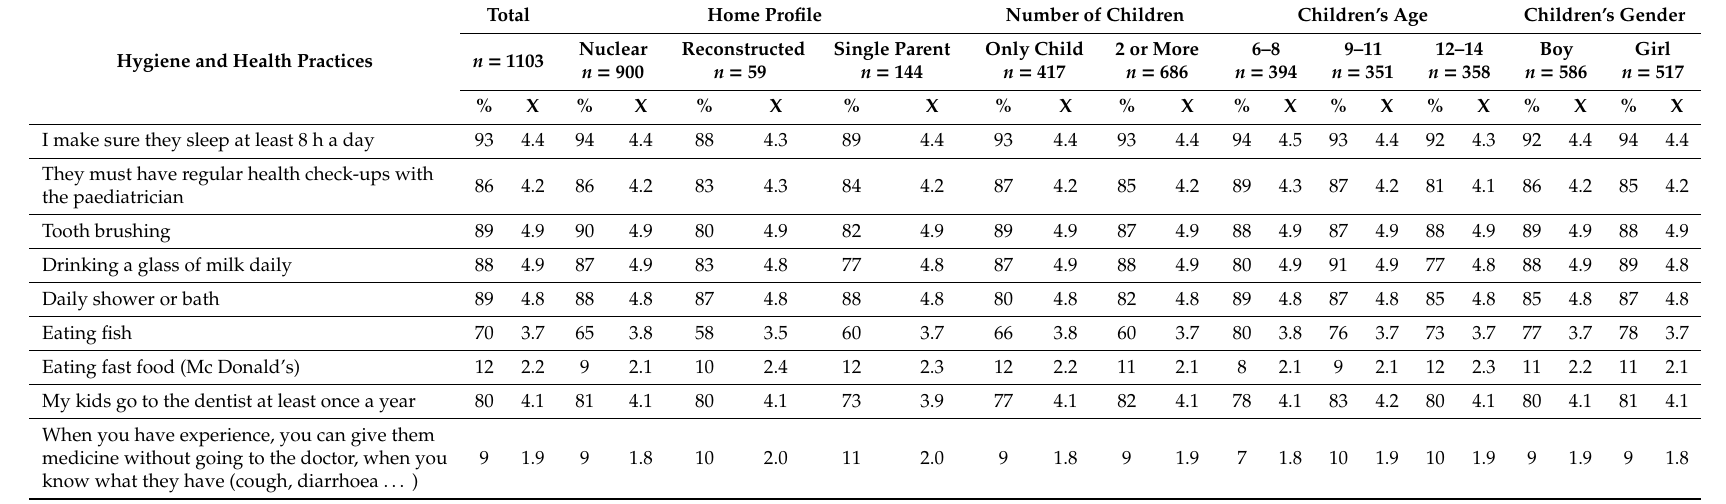
Table 4. Percentage and averages of hygiene and health practices in families with children aged 6 to 14, according to household profile (nuclear, reconstituted, single parent), number of children, their age and their